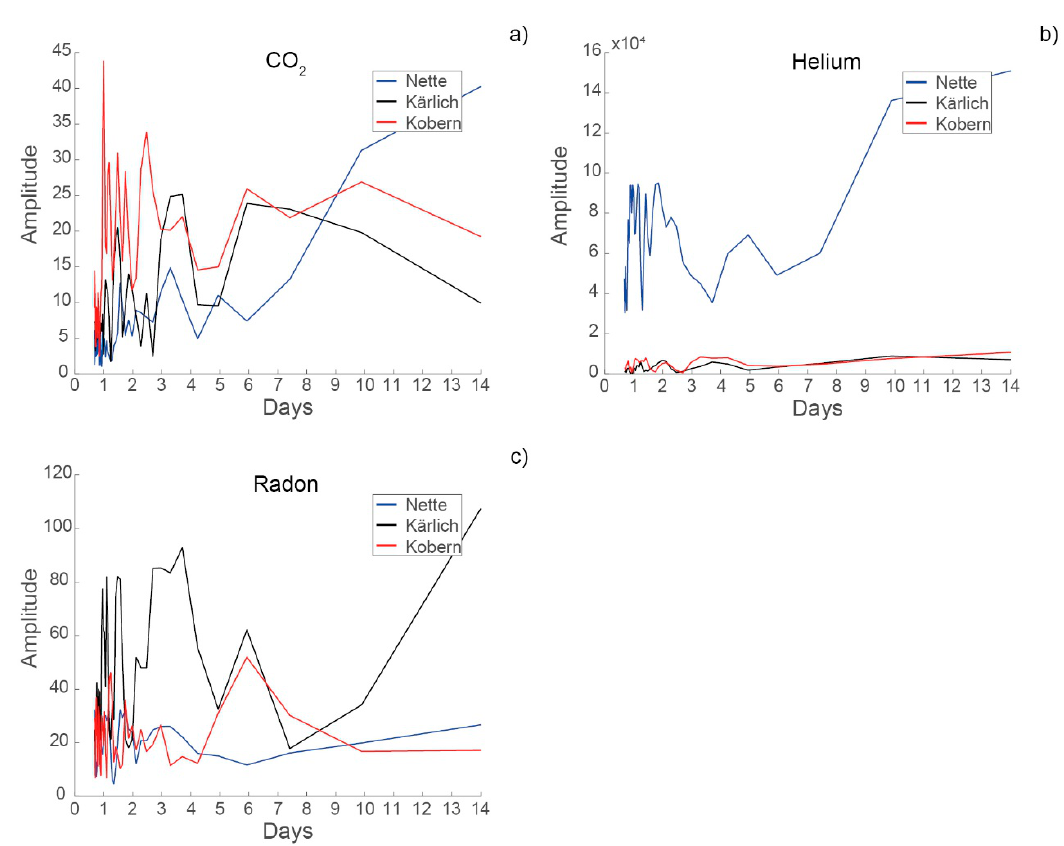
Figure 8. The modified Fourier analysis for the degassing patterns of CO 2 ( a ), He ( b ), and Rn ( c ), in the mineral springs for the 4-W campaign. Longer periods than 14 days are shown in Table A2.